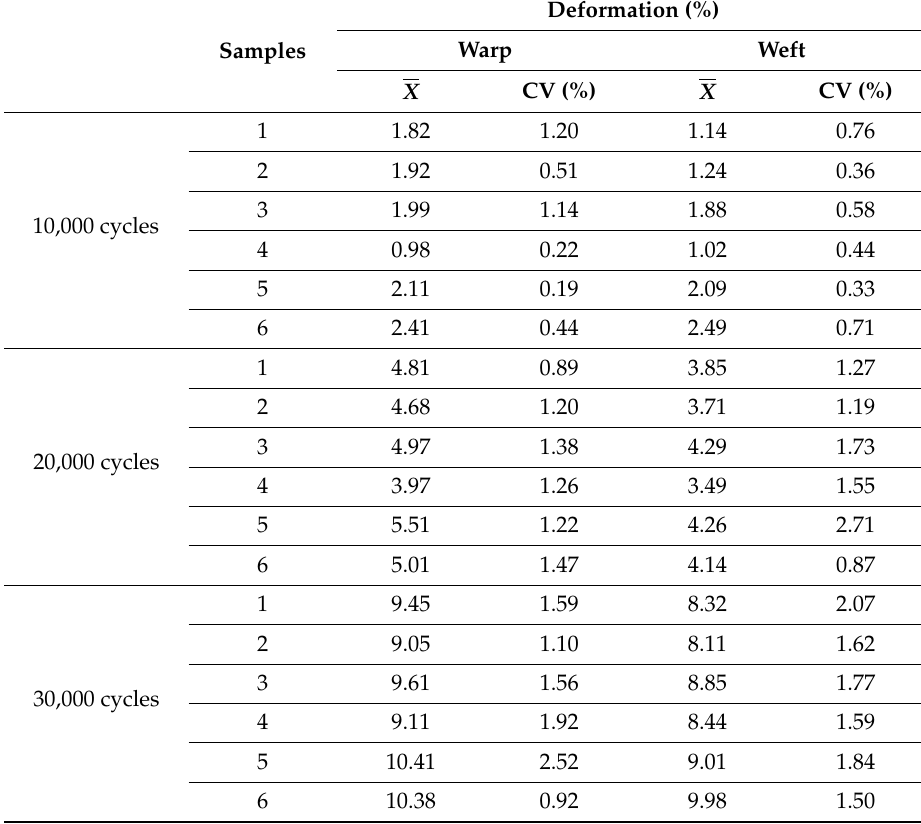
Table 5. Woven fabric deformations in the direction of the warp and weft caused by cyclic stresses. Deformation (%) Warp Weft Samples X CV (%) X CV (%) 1 1.82